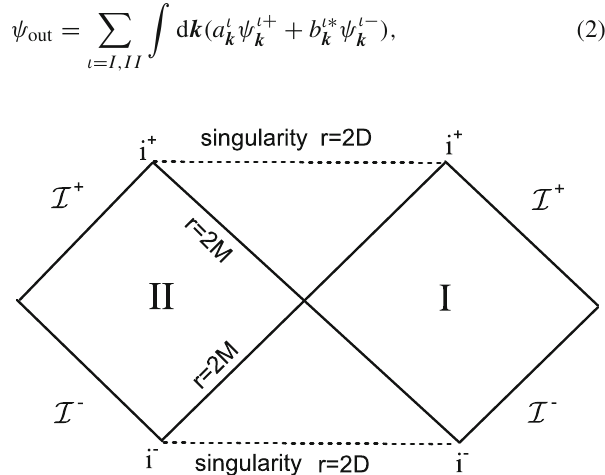
Fig. 1 The Penrose diagrams for the GHS dilation black hole can be